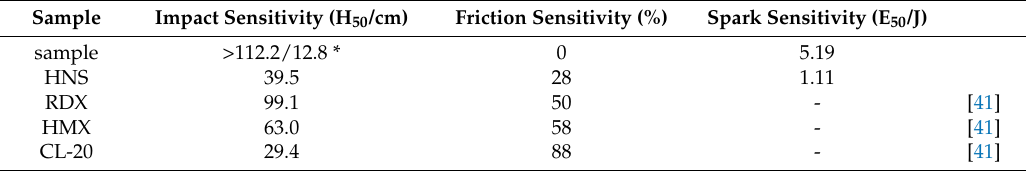
Table 1. Impact, Spark, and Friction Sensitivity of the sample, raw HNS and other